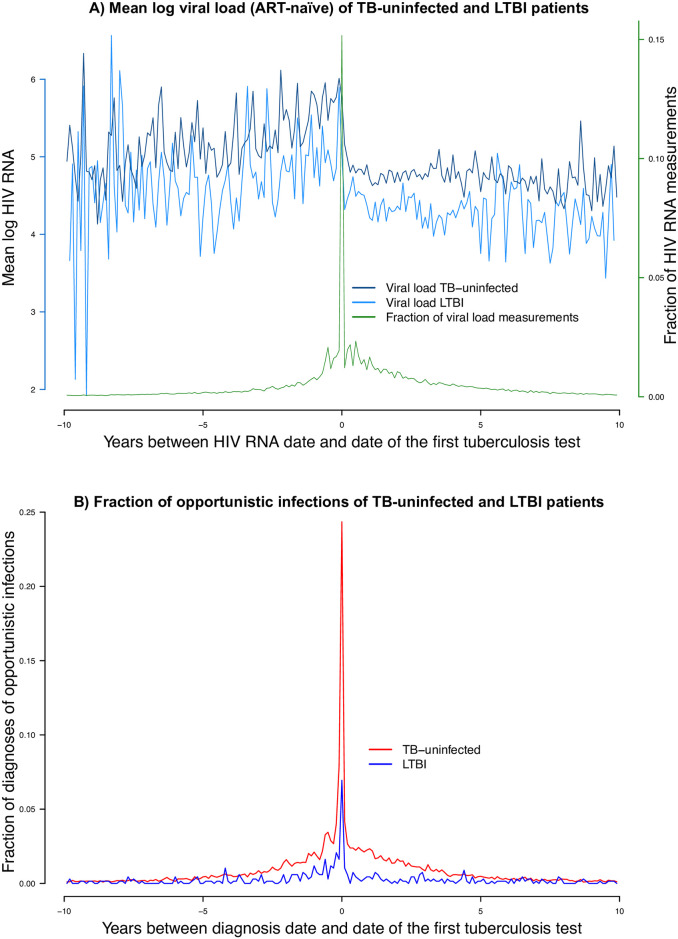
Timing of the studied events: (A) Mean log viral load measurements of TB-uninfected and LTBI patients and (B) fraction of OIs of TB-uninfected LTBI patients (see S3 Data for the underlying numerical values).ART, antiretroviral therapy; LTBI, latent tuberculosis infection; OI, opportunistic infection; TB, tuberculosis.